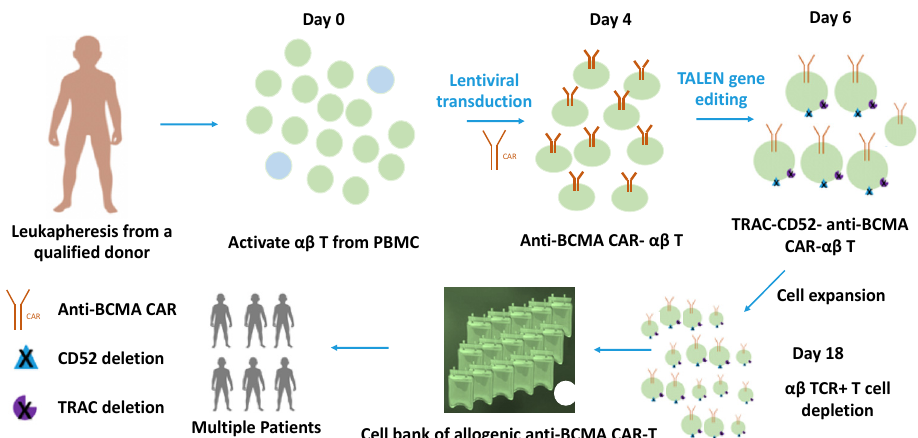
Figure 2. The general cell manufacturing process of gene edited- αβ T cells.